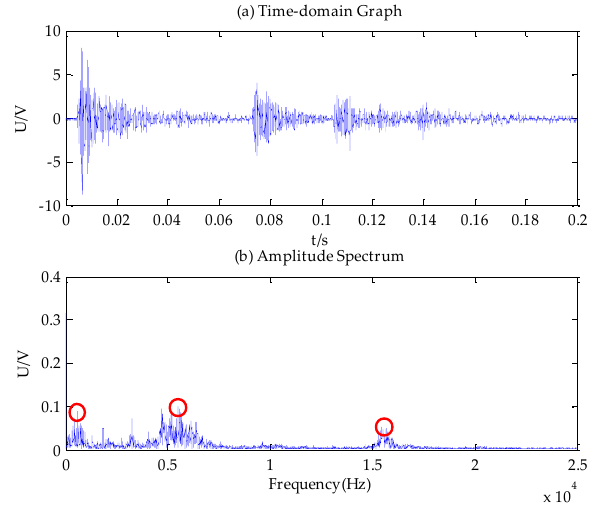
Figure 5. Time–frequency diagram of the main contact looseness signal.